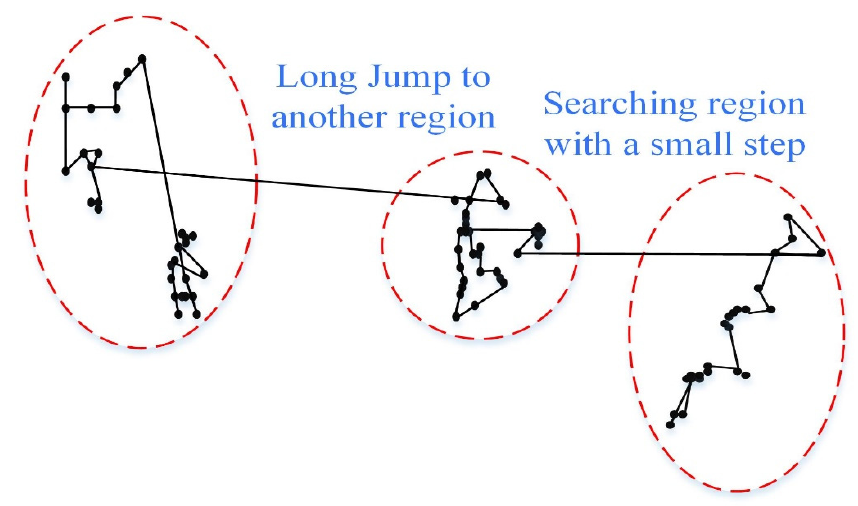
Figure 5. Lévy flight random walk in a two-dimensional plane. Figure 5. L é vy flight random walk in a two-dimensional